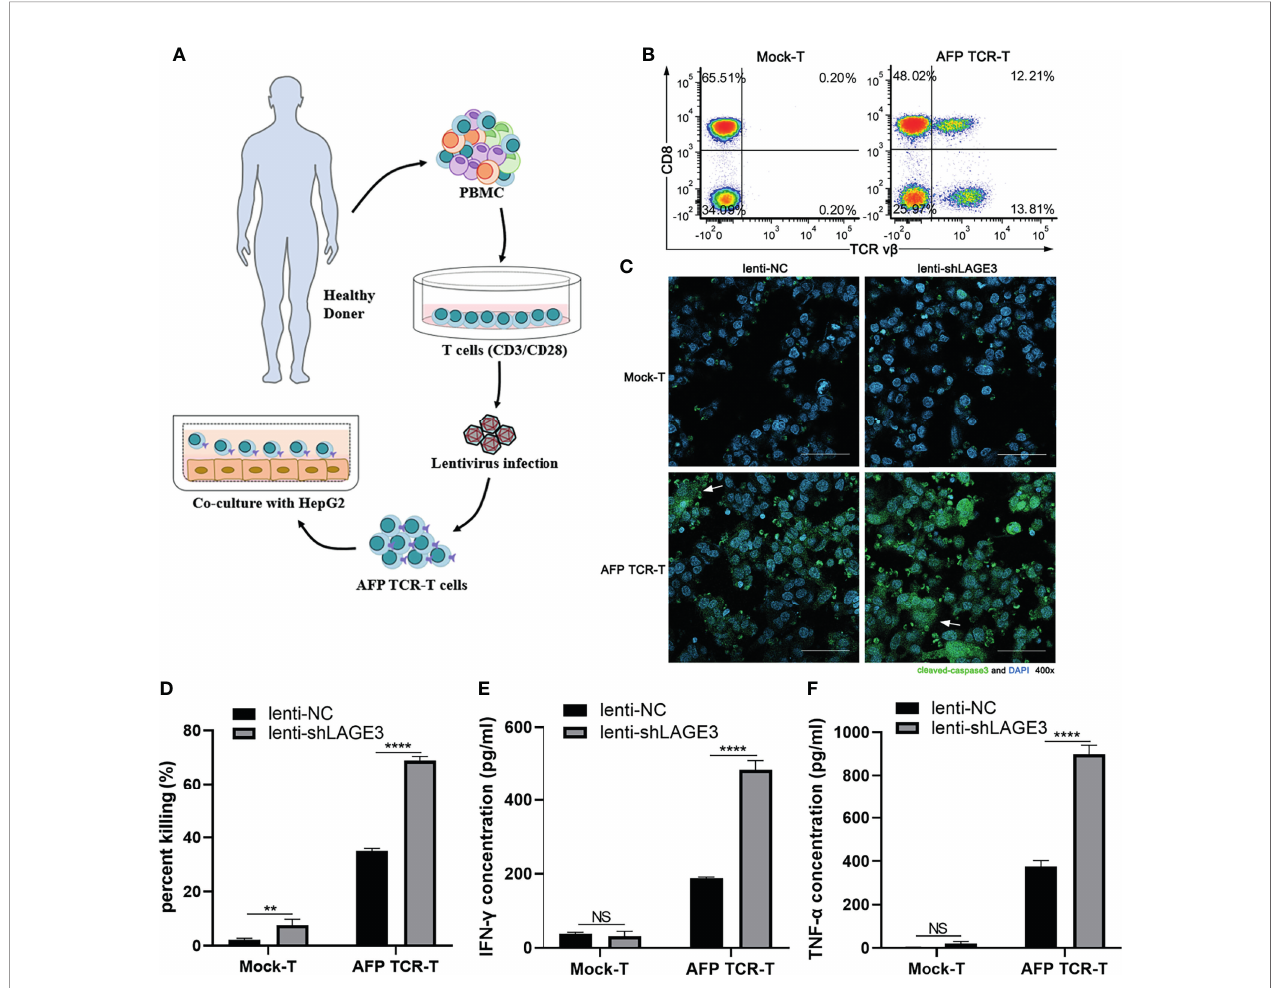
FIGURE 11 | LAGE3 knockdown could enhance the sensitivity of cell death induced by cytotoxic T cells. (A) The fl owchart of engineering AFP TCR-T cells. (B) Flow cytometry was used to detect the ratio of AFP speci fi c cytotoxic T cells (TCR v b + CD8 + ) in AFP TCR-T cells. (C) The cleaved caspase-3 expression of HepG2 transfected with lenti-NC or lenti-shLAGE3 detected using immuno fl uorescence. (D) The killing ratio assessed by detecting LDH in co-culture supernatant. (E, F) The levels of IFN- g and TNF- a in co-culture supernatant. ** P < 0.01, **** P < 0.0001 compared with corresponding control groups. NS, no signi fi